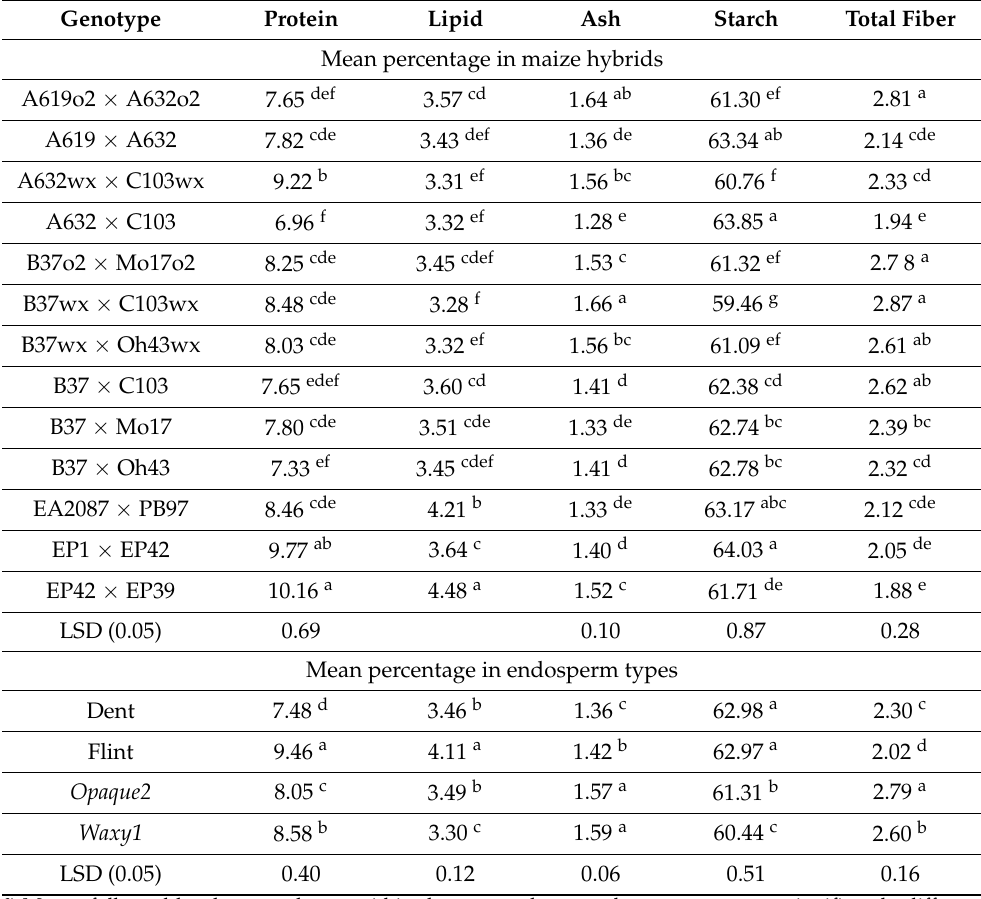
Table 2. Mean α percentage, on a wet weight basis (13% grain moisture content), of nutrients in maize hybrids with high amylopectin ( waxy1 ) or protein ( opaque2 ), and dent or flint kernel and in the four endosperms types evaluated during two years in two locations of Pontevedra (Northwestern